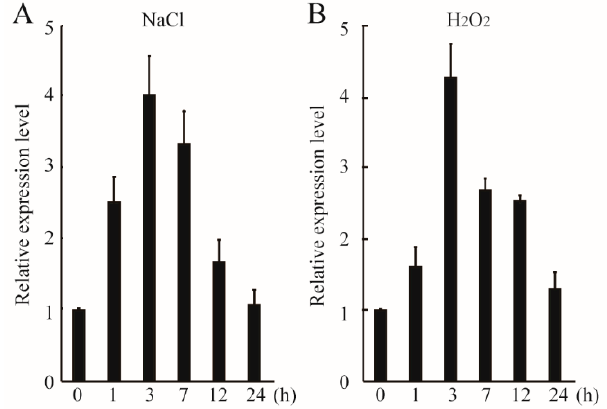
Figure 1. Transcript levels of GmCIPK2 under salt and oxidative stresses. The expression levels of GmCIPK2 under ( A ) NaCl treatment and ( B ) H 2 O 2 treatment were measured in qRT-PCR assays. Gmtubulin was used as an internal reference. Each data point represents the mean (±SE) of three independent biological replicates.